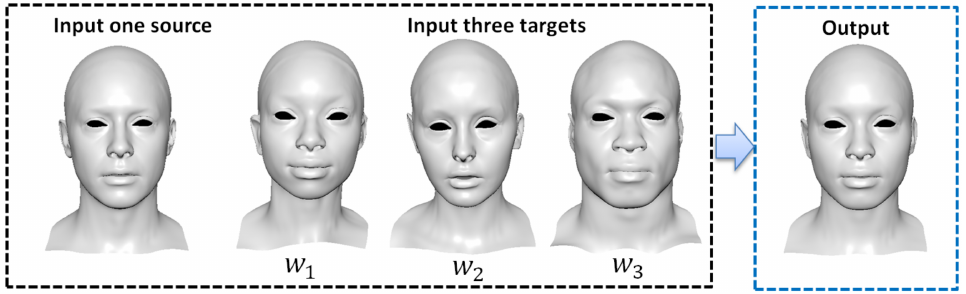
Figure 8. Facial blendshapes by using Equation (29) to blend PDE surface patches on one source facial model and three target facial models with w 1 = 0.33, w 2 = 0.33, w 3 = 0.34, and t = 1.